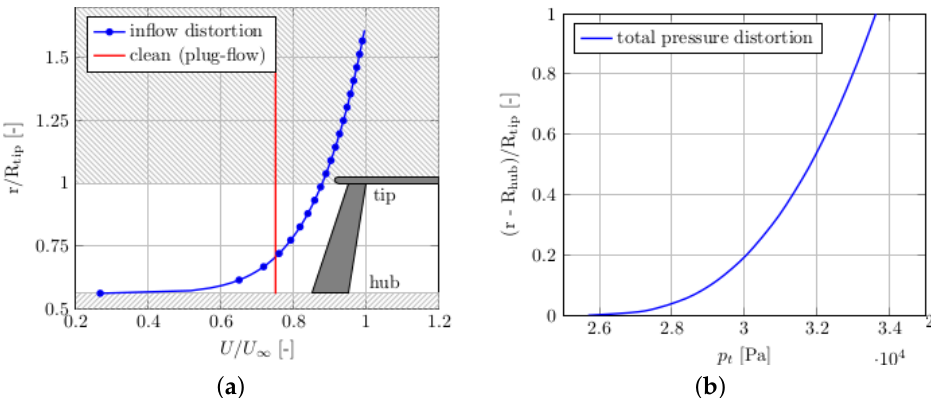
Figure 8. Illustration and definition of used inflow distortion. ( a ) Exemplary shape of the inflow distortion and Clean configuration. ( b ) Used total pressure distortion.